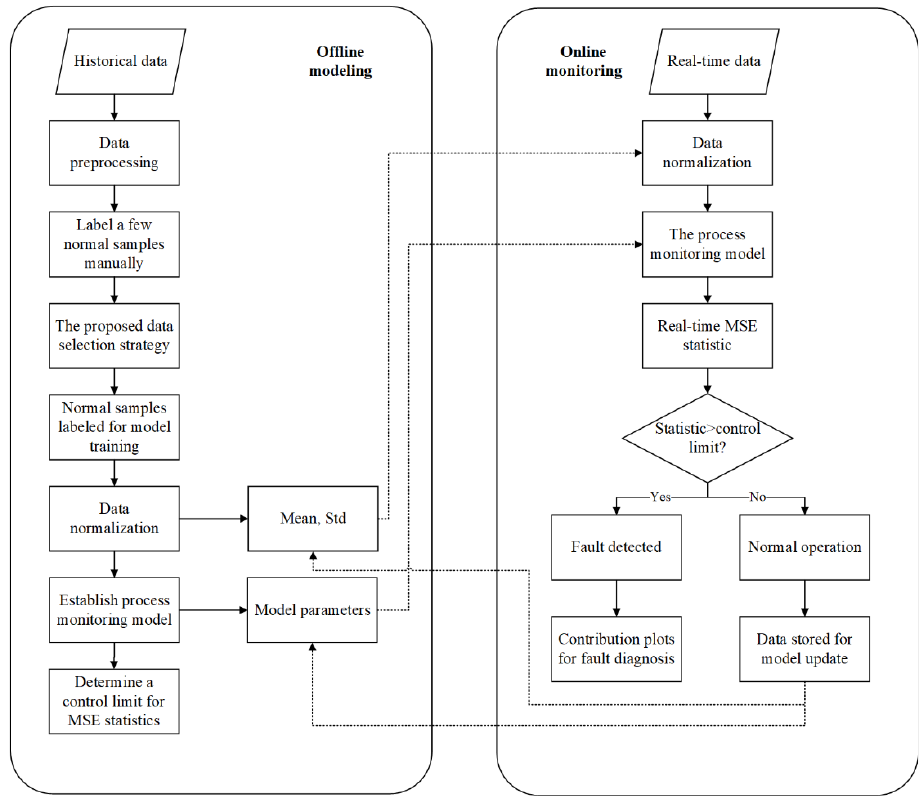
Figure 2. The flowchart of the proposed industrial process monitoring framework.